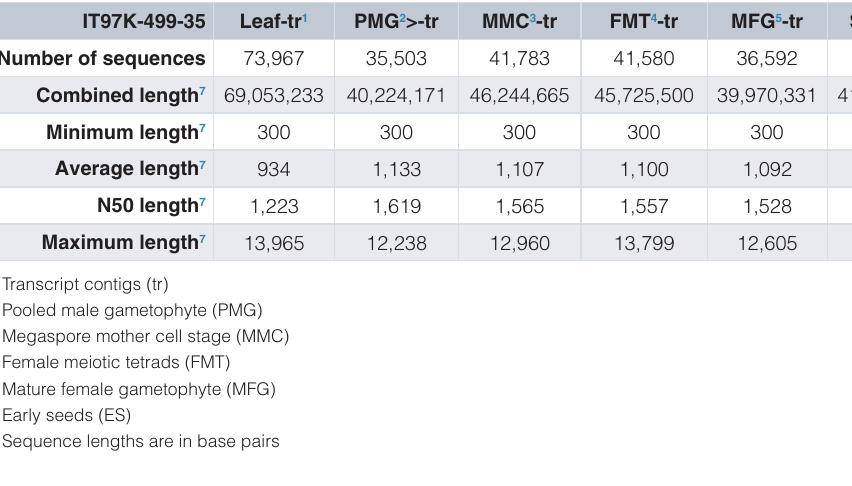
Table 7. Proportion of filtered raw RNASeq paired-end reads that uniquely align to the assembled genomic DNA sequence sets from IT97K-499-35 and IT86D-1010, and to the Vigna unguiculata genome v1.0 assembly of IT97K-499-35. Alignments by ‘biokanga align’, with up to 3 substitutions per 100 base pairs, paired-ends retained within 1 kilobase of each other and auto end-trimming of reads where required.